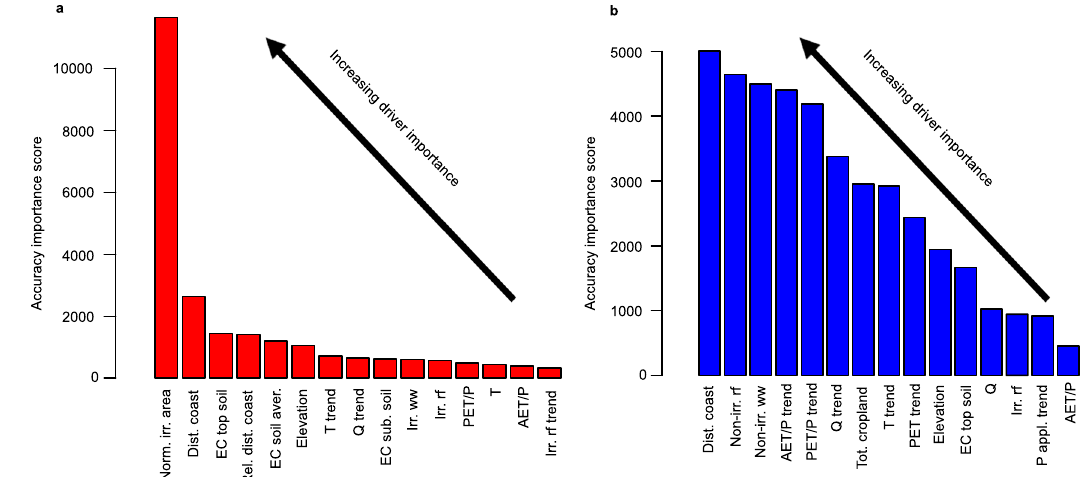
Fig. 6 Relative driver contributions for predictions of salinity levels across trends. Bar charts show the relative importance of driver variables in predicting salinity levels in sub-basins with ( a ) increasing salinity trends (red bars) and ( b ) decreasing salinity trends (blue bars), using the conditional permutation importance method within the Random Forest approach. The accuracy importance score (y-axis; unitless) represent the relative importance of each predictor variable in achieving the prediction capacity of the Random Forest model (note the different y-axes in panel a and b and that the absolute values of the scores should not be interpreted, only the relative scores between